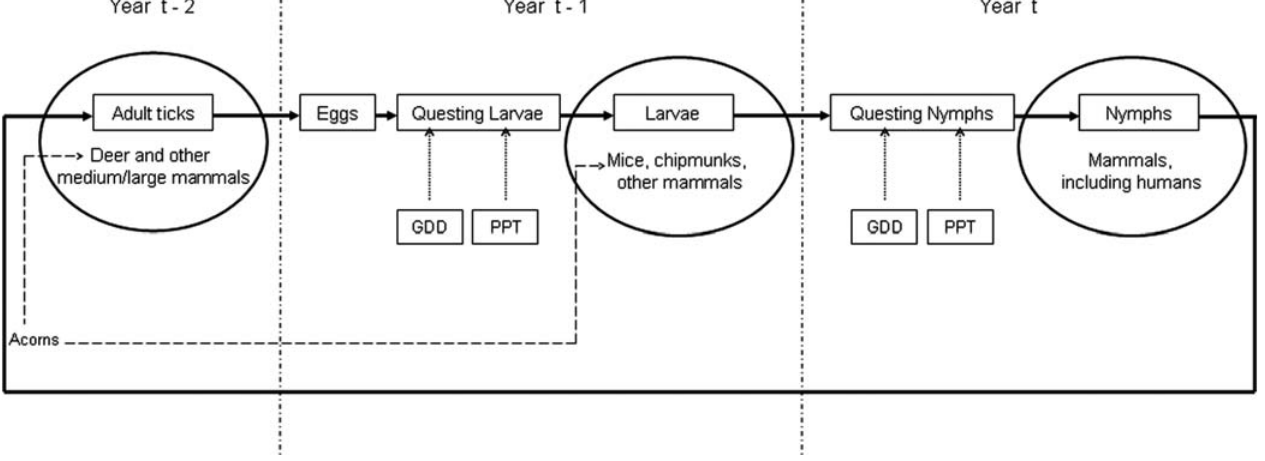
Figure 1. Diagram of Life Cycle of the Blacklegged Tick (I. scapularis) Shows the four life stages, egg, larva, nymph, adult, and the times during the life cycle that both abiotic (GDD, PPT), and biotic (acorns and various hosts) factors might exert influence. Year t is the year during which nymphal ticks seek hosts, including humans, and represents the focal year with respect to risk of exposure. DOI: 10.1371/journal.pbio.0040145.g001